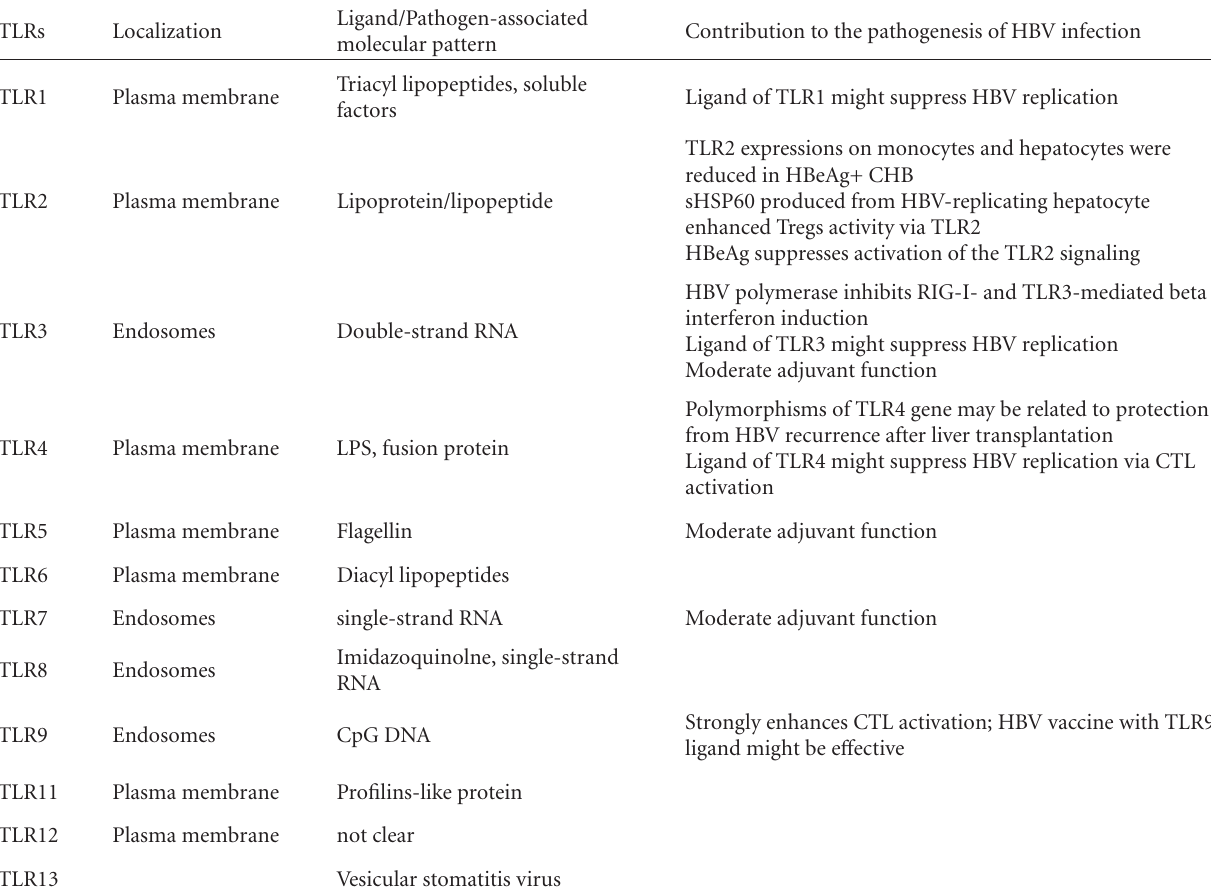
Table 1: TLR signaling a ff ecting the immunopathogenesis of HBV